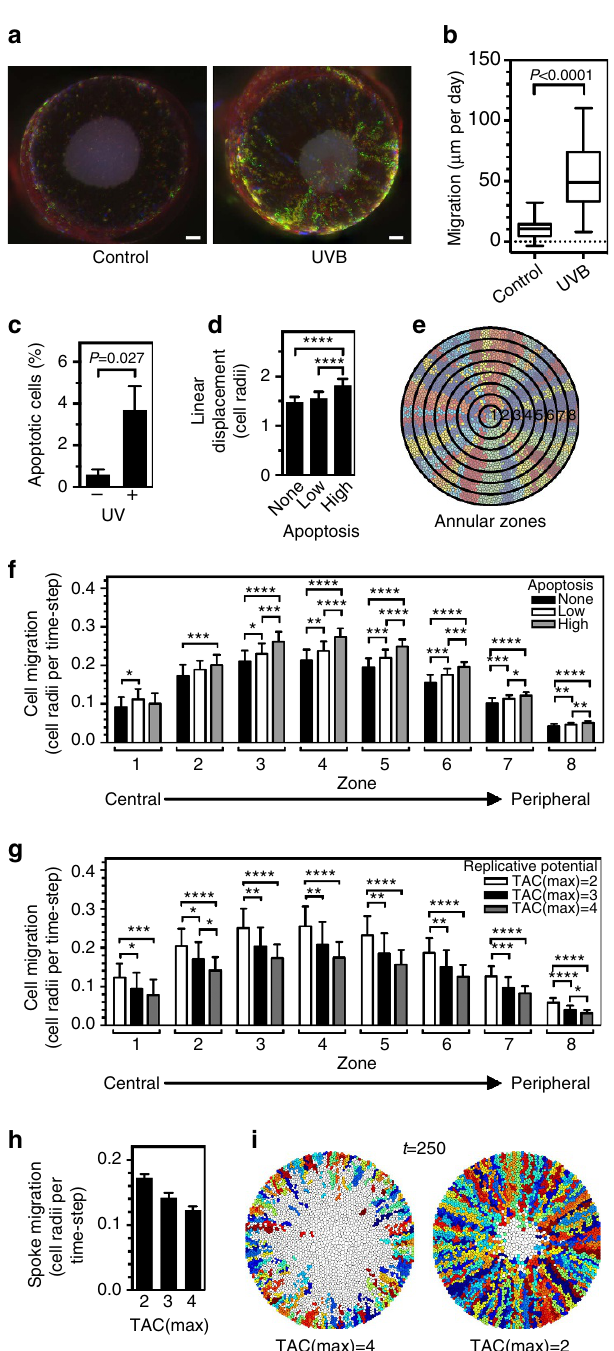
Figure 3 | UVR damage drives centripetal migration of corneal epithelial cell clones. ( a ) One eye of each K14CreERT2-Confetti mouse was irradiated with a single exposure of UVR (150mJcm (cid:3) 2 ). Eyes were obtained 7 days later and fluorescently imaged. The control (left) and irradiated eye (right) from a representative mouse are shown. Scale bar, 200 m m. ( b ) The lengths of contiguous streaks emanating from the limbal regions of both eyes of four mice were quantified. Box and whiskers represent the 25–75 percentile interval and the range,